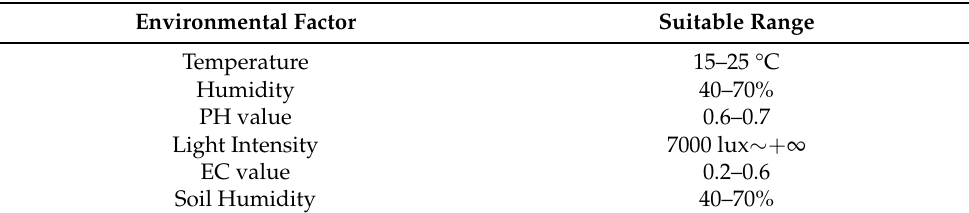
Table 4. Suitable range of different environmental factors for the growth of leafy greens.